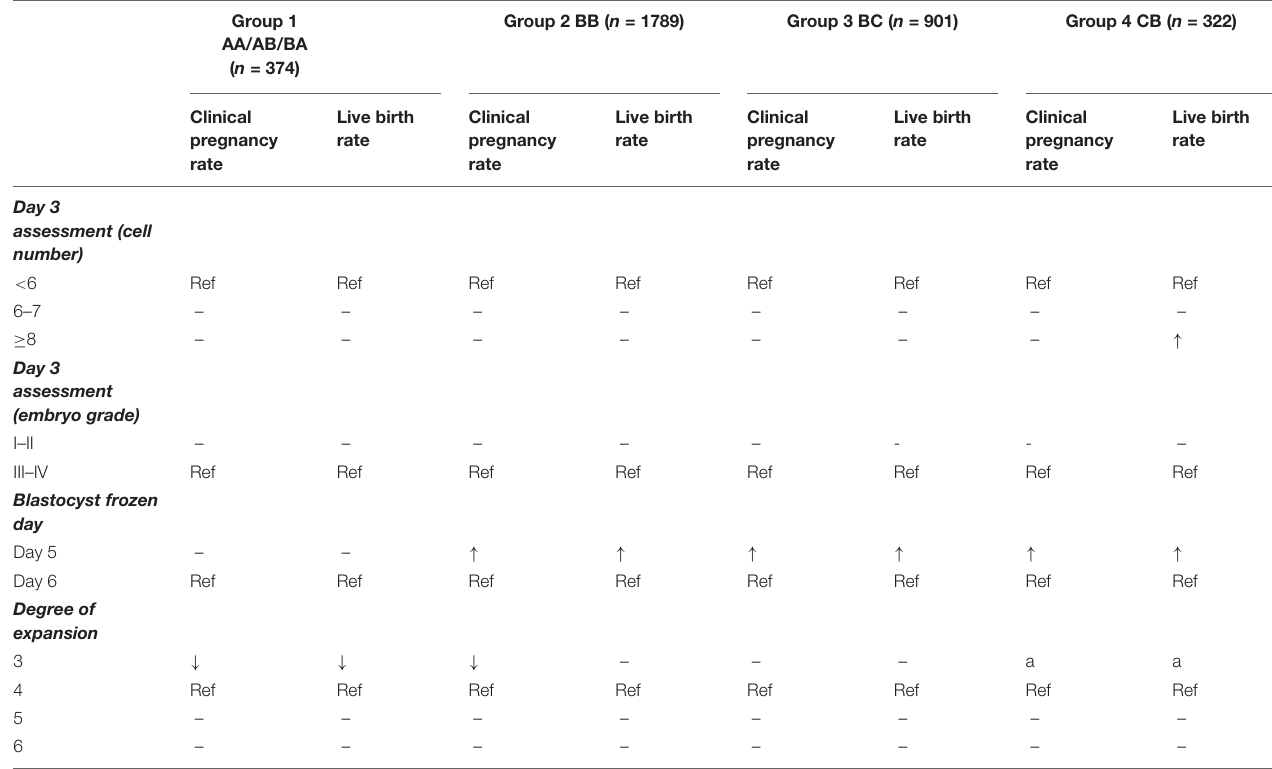
TABLE 3 | The summarized reference values of cleavage-stage embryo quality and embryo development speed for clinical pregnancy rate and live birth rate in different grade